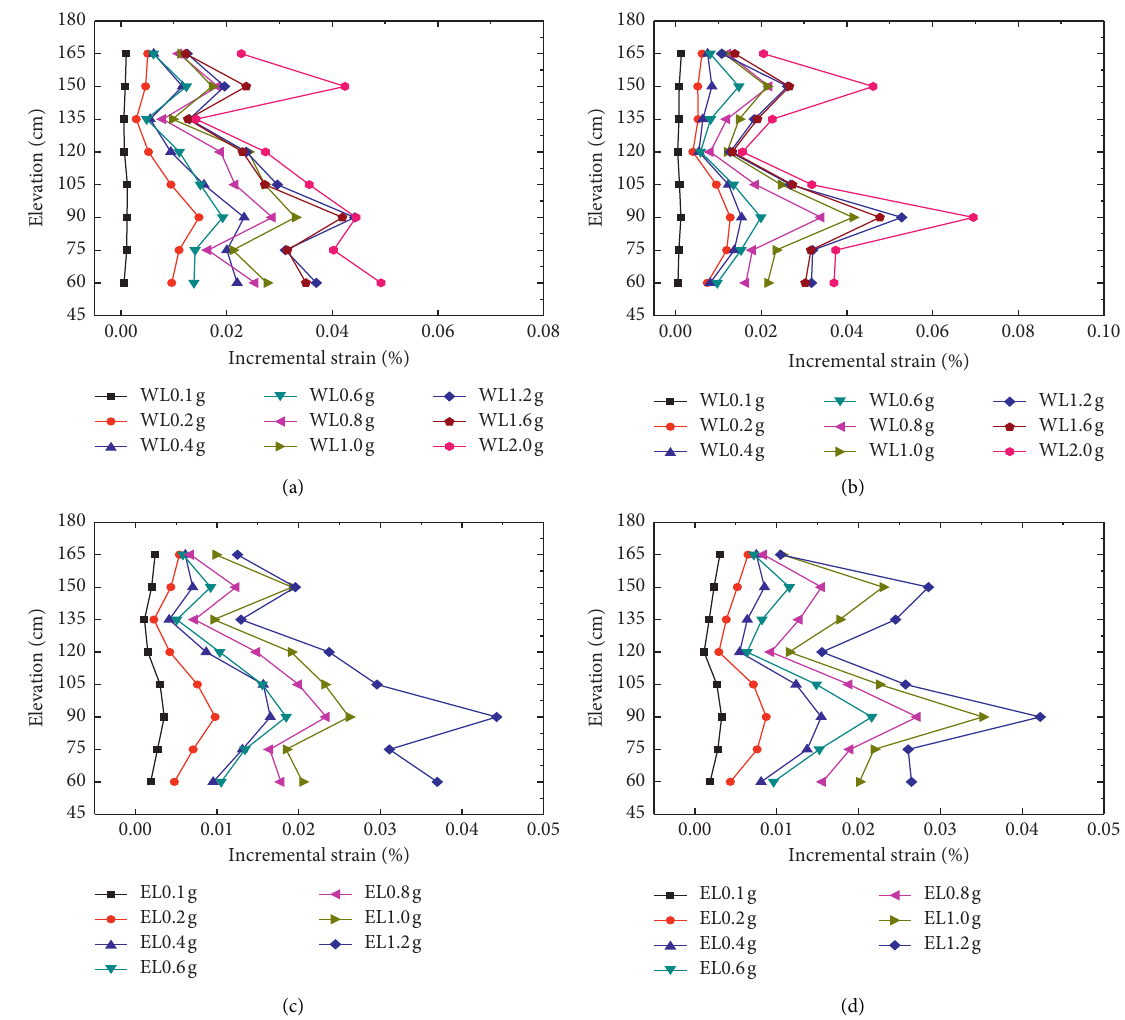
Figure 17: Distribution of strain in T 6 and T 7 for specimen 2. (a) T 6 under WL. (b) T 7 under WL. (c) T 6 under EL. (d) T 7 under